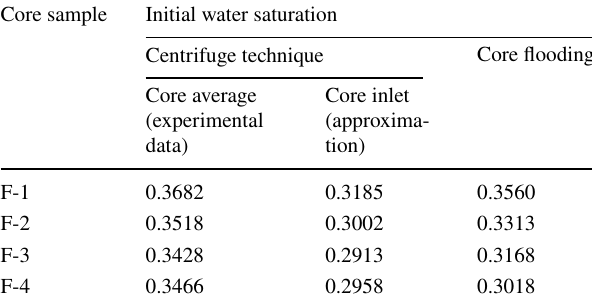
Table 3 Initial water saturation from centrifuge and core flooding methods Core